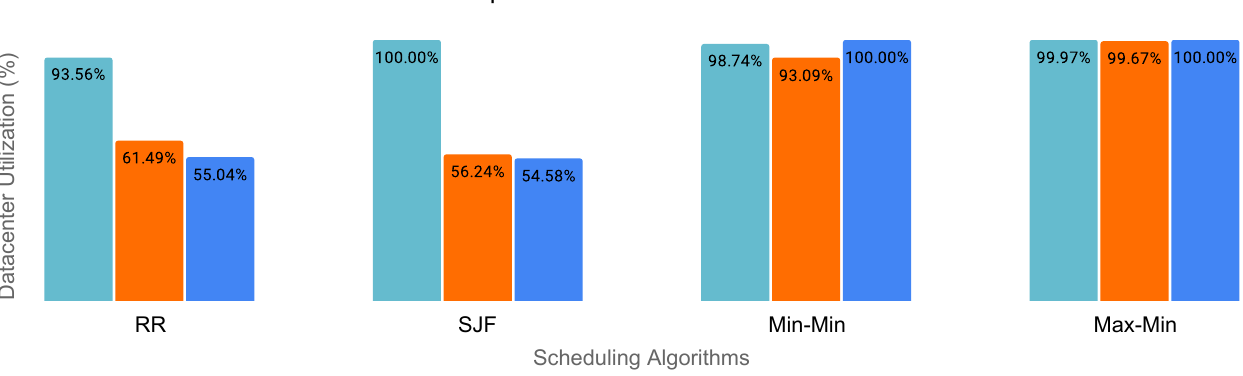
Figure 7. Datacenters’ resource utilization for Experiment 2 (8000